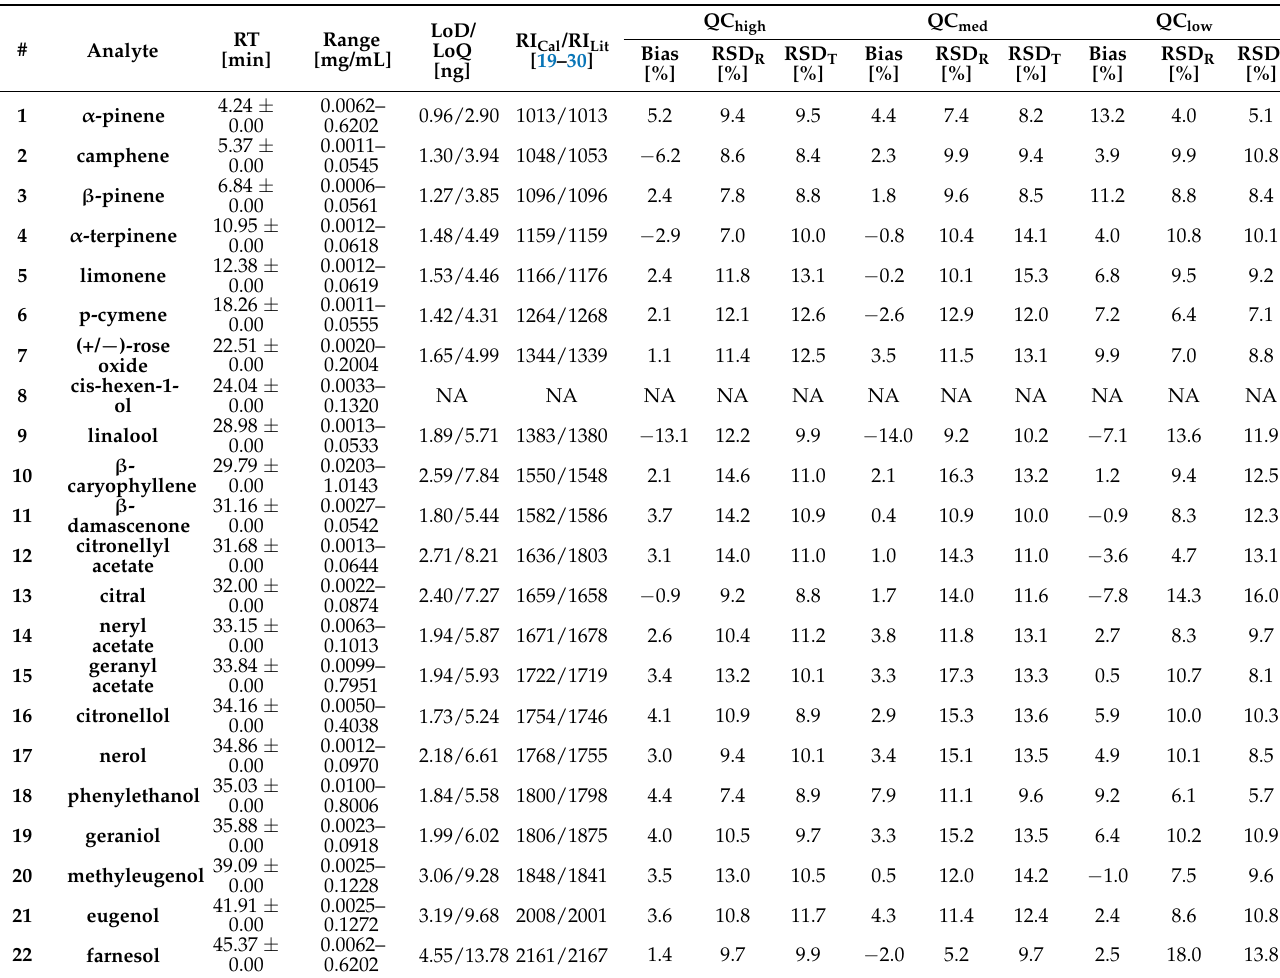
Table 1. Retention times and results for the validation of 22 rose oil compounds analysed on a DB-wax column with GC-FID. RI Cal depicts the calculated RI values, while RI Lit are the ones obtained from